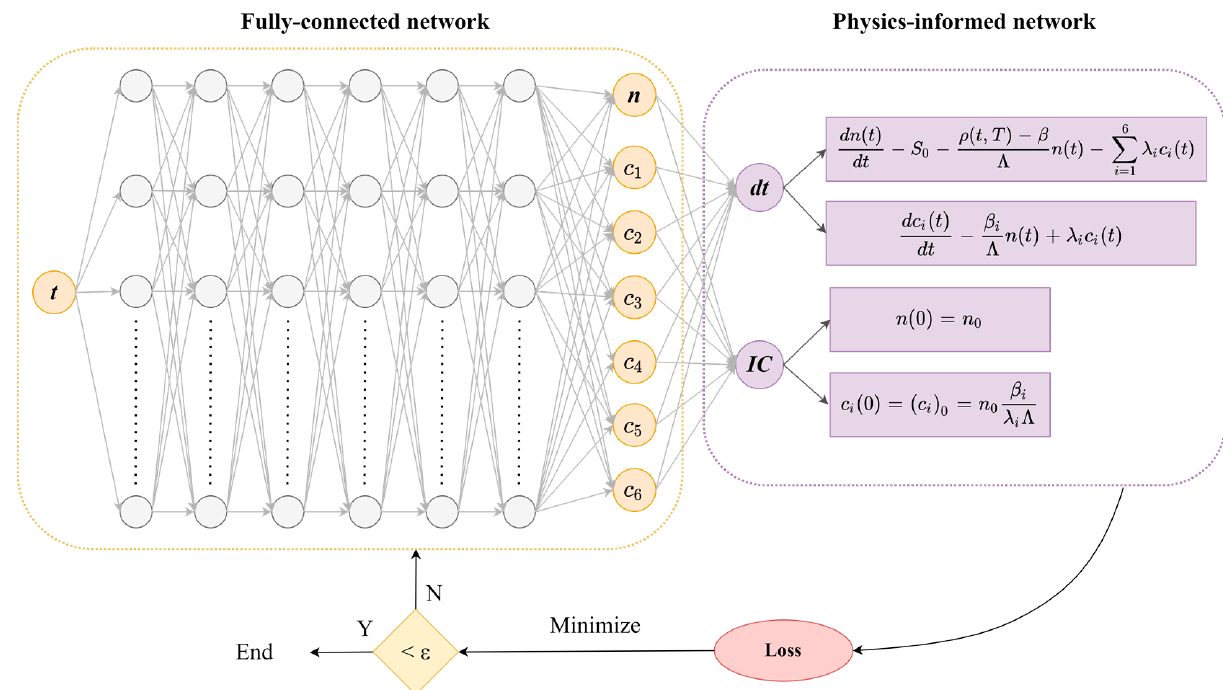
Figure 6. Schematic of PINN for solving the PKEs with ICs. The input to surrogate network is time, t , and the output is the solution vector [ n ( t ) , c 1 ( t ) , c 2 ( t ) , c 3 ( t ) , c 4 ( t ) , c 5 ( t ) , c 6 ( t )] T . The residual network tests if the solution vector satisfies the PKE governing equations and the ICs.